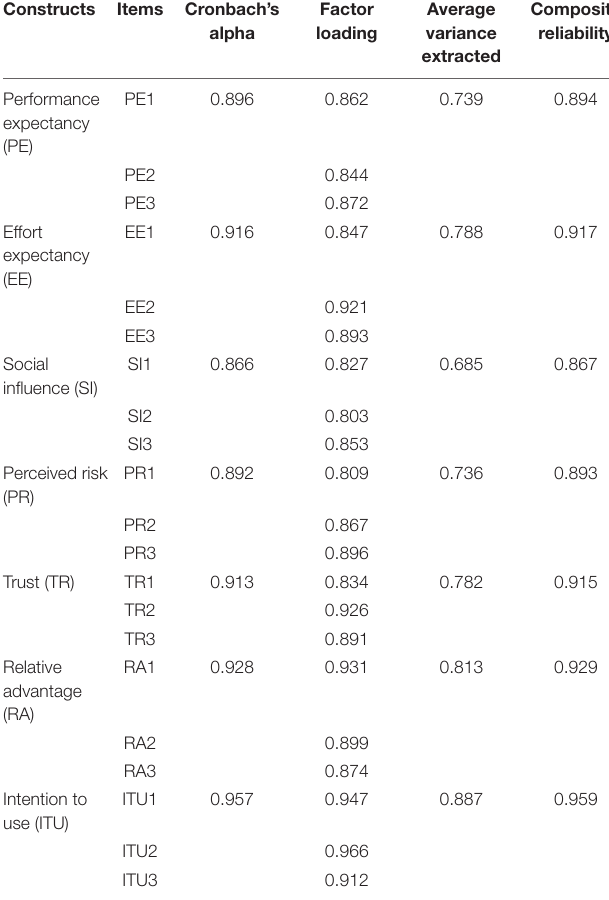
TABLE 1 | Validity and